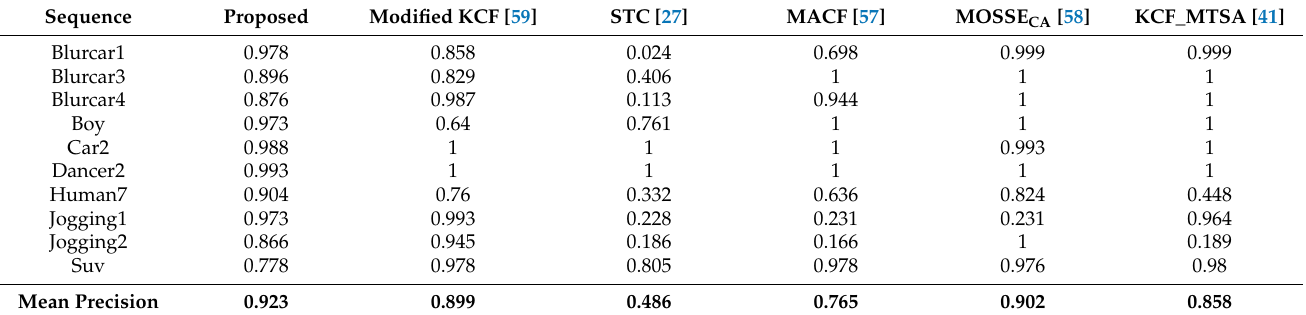
Table 1. Distance precision rate.